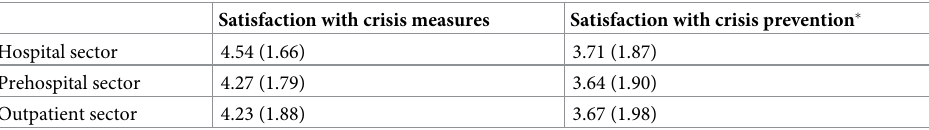
Table 3. Satisfaction with short-term crisis measures and crisis